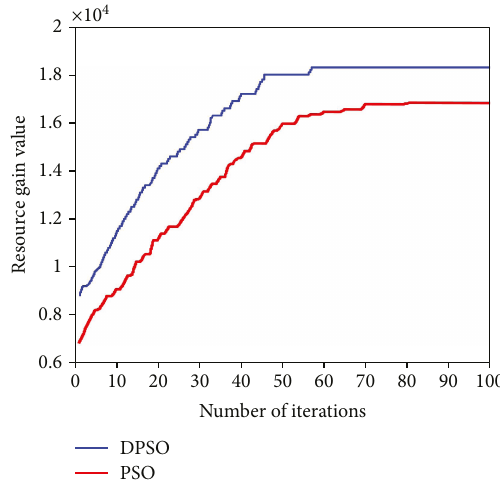
Figure 14: Comparison between PSO and DPSO. Table 3: Comparison between PSO algorithm and DPSO algorithm. Algorithm